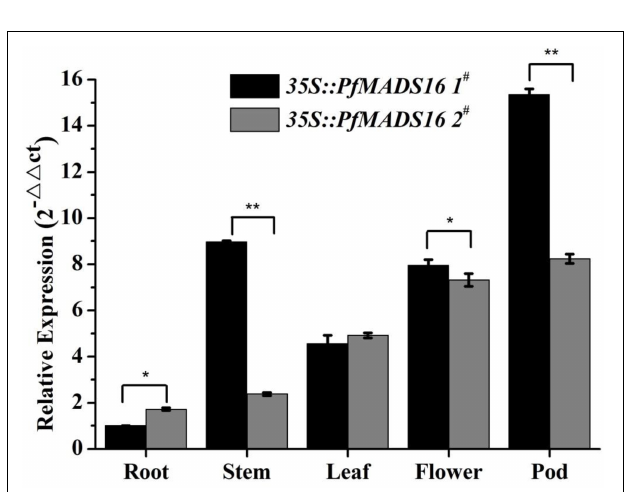
FIGURE 5 | RT-qPCR analysis of PfMADS16 gene expression in different tissues of plants from two T3 transgenic Arabidopsis lines. Error bars represent standard error calculated from three biological replicates. An actin homologous gene ( ACTIN2 ) of Arabidopsis was used as an internal control. *indicates significant difference, p < 0.05; **indicates significant difference, p <